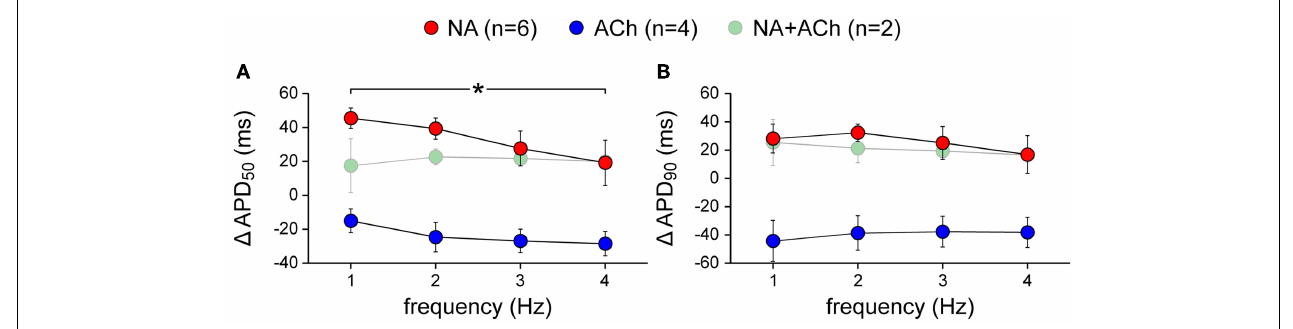
(“NA + ACh,” green symbols). Cells were stimulated at 1–4Hz. Asterisk indicates significant difference between stimulus frequencies. (A) Action